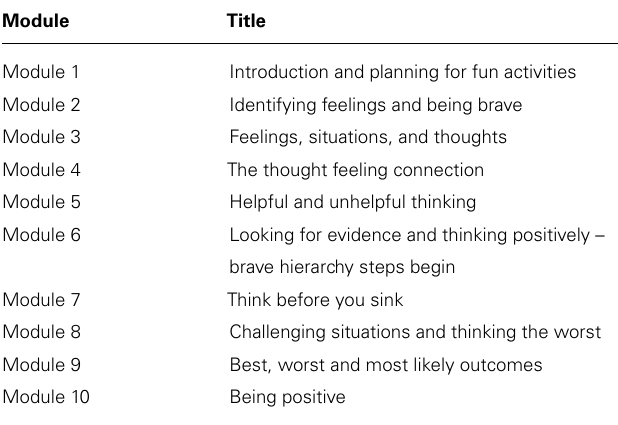
Table 1 | Content of positive thinking